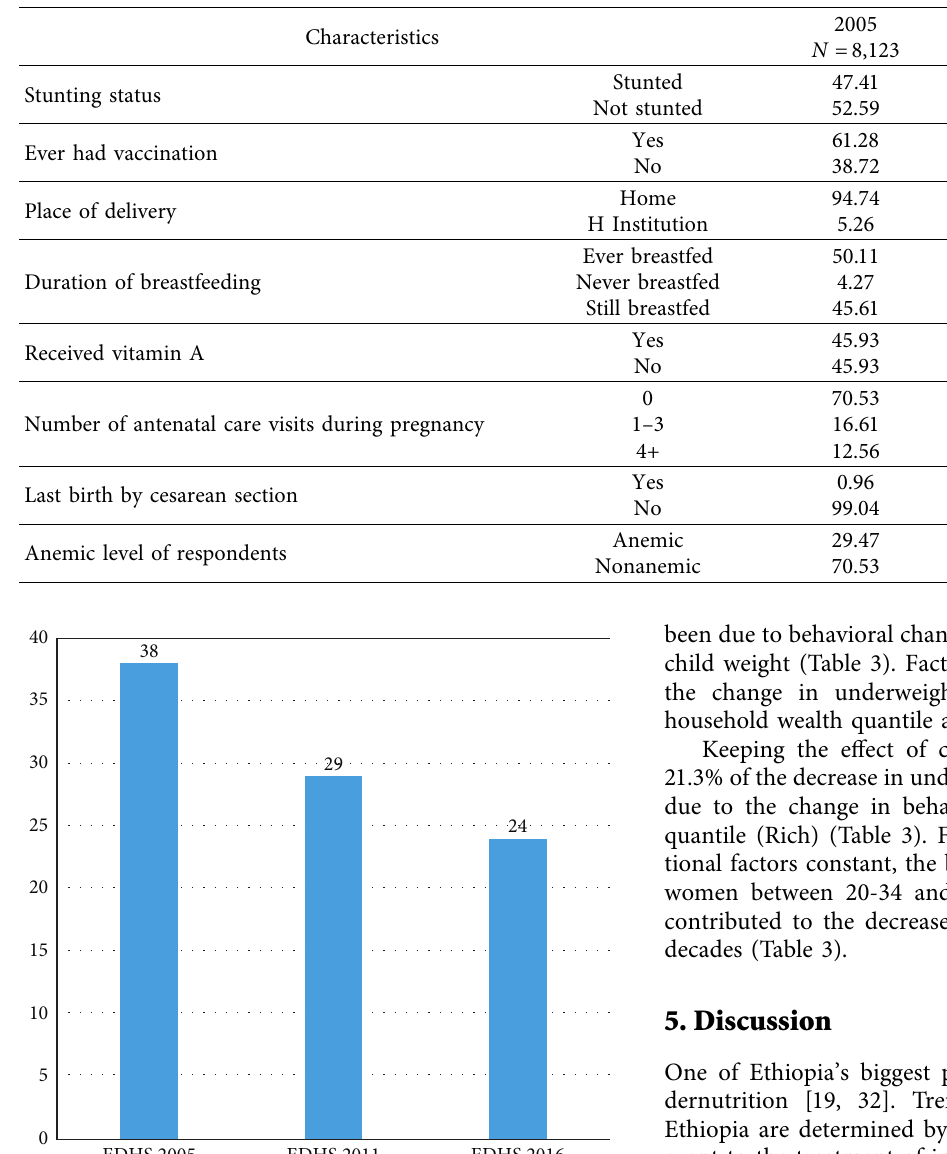
Table 2: Percentage distribution of nutritional and health characteristics among respondents, 2005, 2011, and 2016 EDHS.